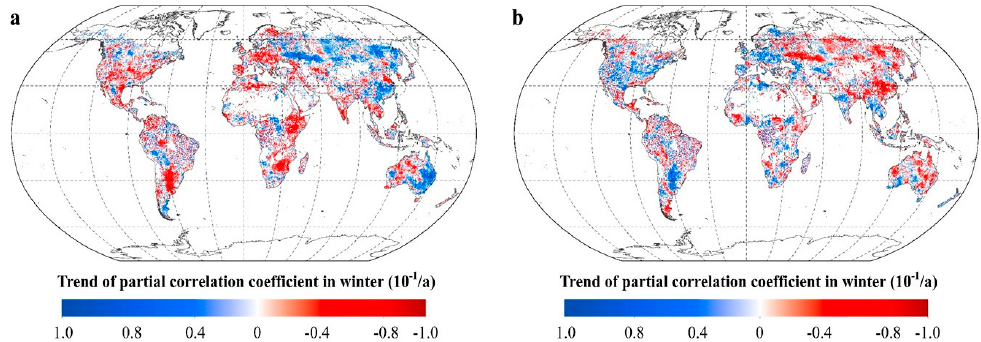
Figure 10. The response of vegetation greenness to the diurnal temperature in winter. ( a . spatial distribution of the temporal trend of the partial coefficients between winter NDVI and T max . b . spa- tial distribution of the temporal trend of the partial coefficients between winter NDVI and T min . Sup- plementary Table S5).